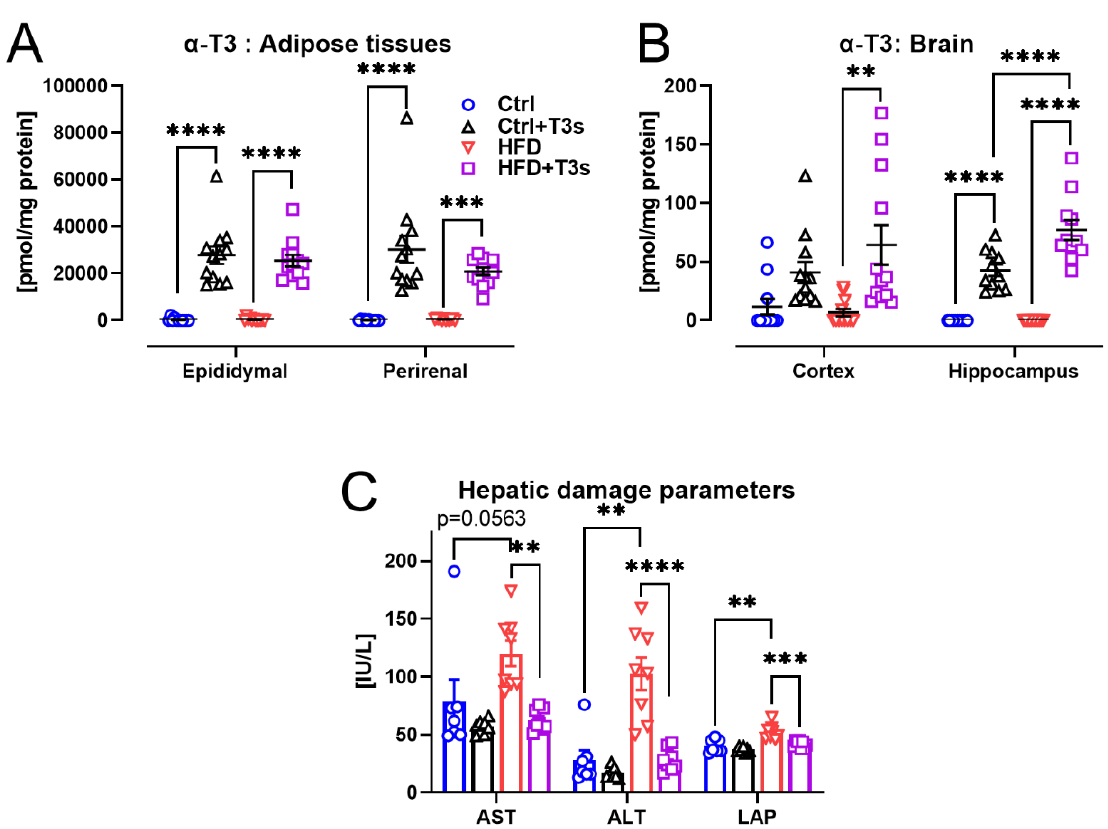
Figure 3. α -T3 levels and serum hepatic parameters. ( A ) α -T3 levels in adipose tissues. (Ctrl, n = 11; Ctrl + T3s, HFD and HFD + T3s, n = 12). ( B ) α -T3 levels in each brain region. (Cortex: Ctrl, n = 11; Ctrl + T3s, HFD and HFD + T3s, n = 12; Hippo.: Ctrl, Ctrl + T3s, HFD and HFD + T3s, n = 11). ( C ) Index of hepatic damage in serum. (Ctrl and Ctrl + T3s, n = 7; HFD and HFD + T3s, n = 8). ** p < 0.01, *** p < 0.001, **** p < 0.0001, two-way ANOVA with the Tukey – Kramer method.